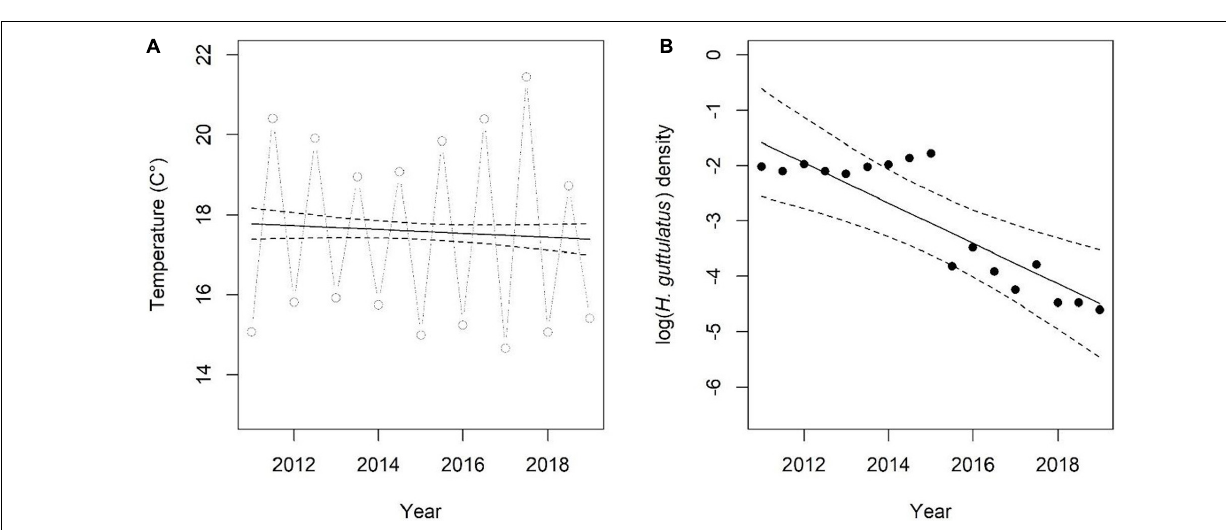
FIGURE 3 | (A,B) Time-series of temperature and H. guttulatus density. Lines indicate fitted values obtained using GLS models. Model details are reported in Table 1